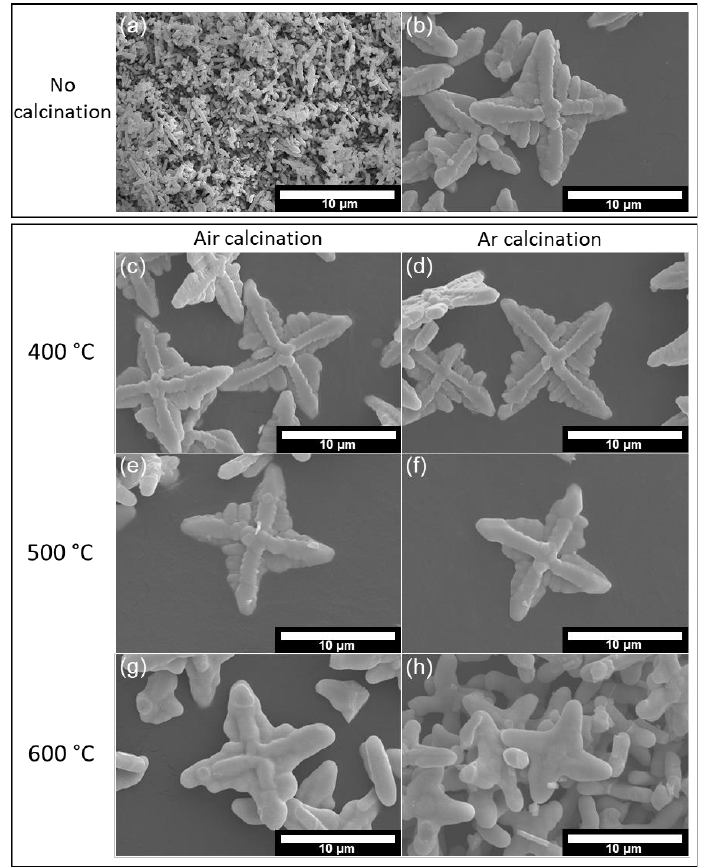
Figure 1. SEM images of ( a ) pristine BiVO 4 , ( b ) KCl-BiVO 4 , ( c ) KCl-BiVO 4 400-air, ( d ) KCl-BiVO 4 400-Ar, ( e ) KCl-BiVO 4 500-air, ( f ) KCl-BiVO 4 500-Ar, ( g ) KCl-BiVO 4 600-air, ( h ) KCl-BiVO 4 600-Ar.